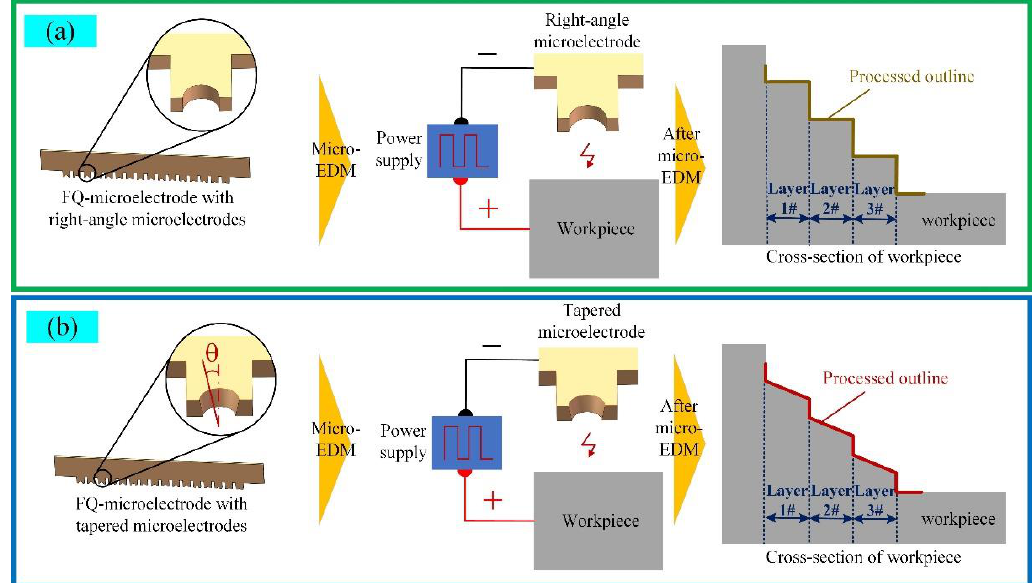
Figure 2. ( a ) Fabricating 3D microstructure based on the FQ-microelectrode without tapered structure; ( b ) Fabricating 3D microstructure based on the FQ-microelectrode with tapered structure.